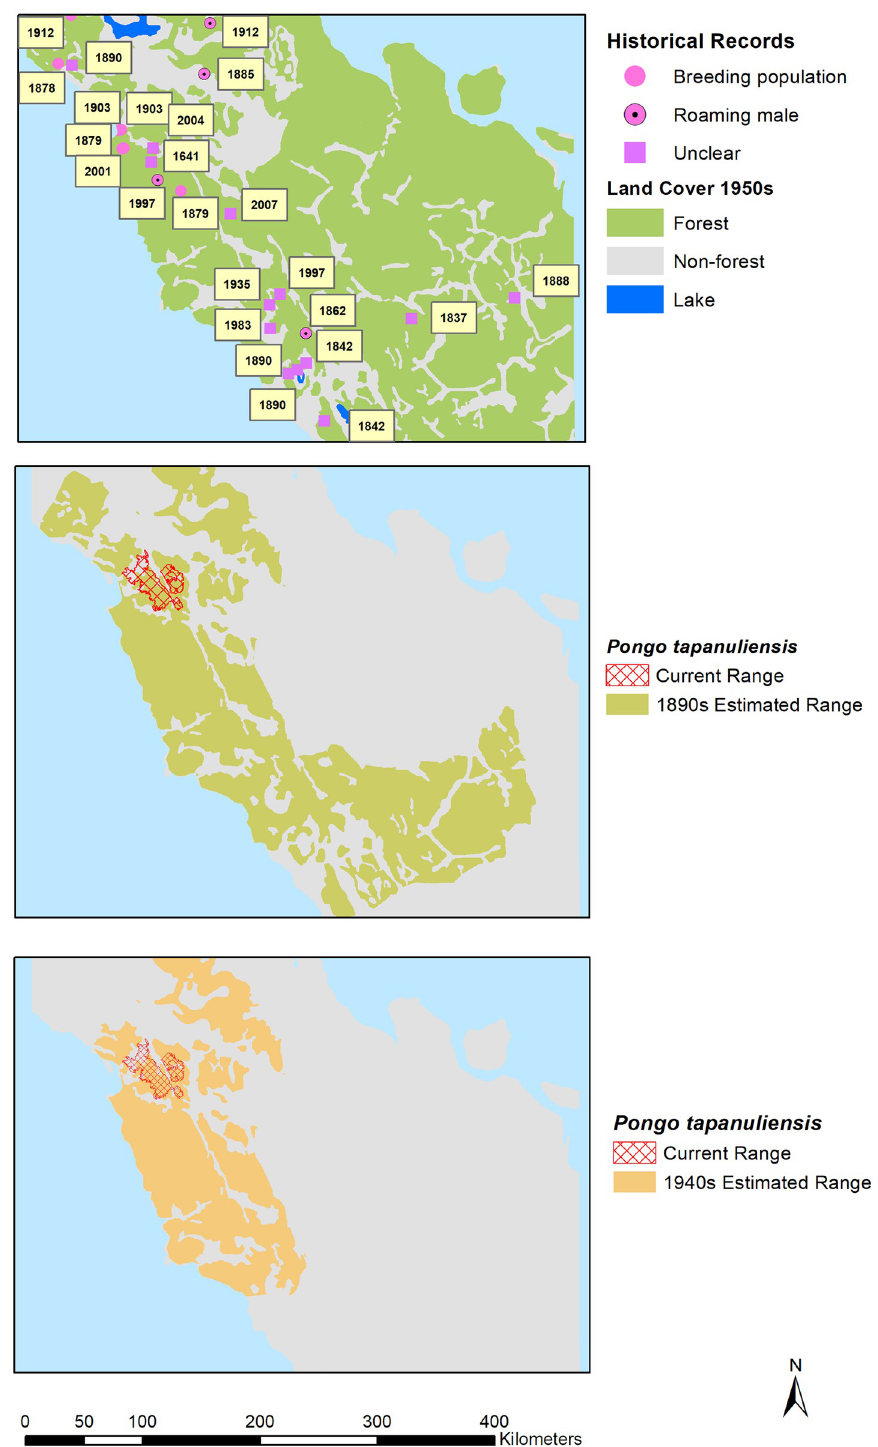
Fig 3. Top panel: Years of historic orangutan records. Middle panel: Estimated historic range in 1890s. Bottom panel: Estimated historic range in 1940s. Reprinted from [26] under a CC BY license, with permission from PT Balai Pustaka, original copyright